Question: Summarize what this figure shows in one sentence.
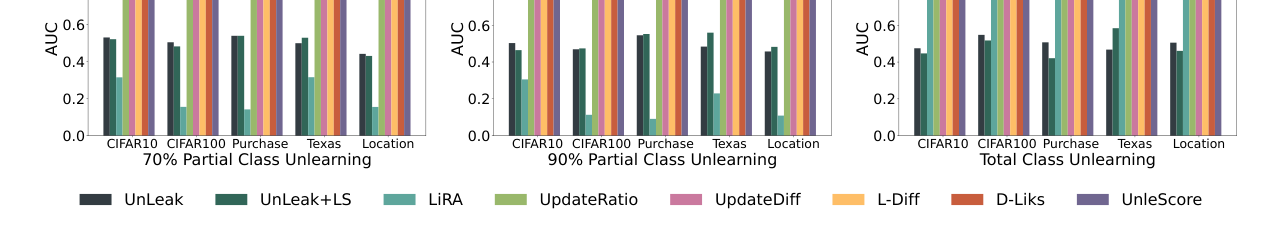
Answer: Statistical results (AUC) of metric utility on 3 types of exact unlearning.